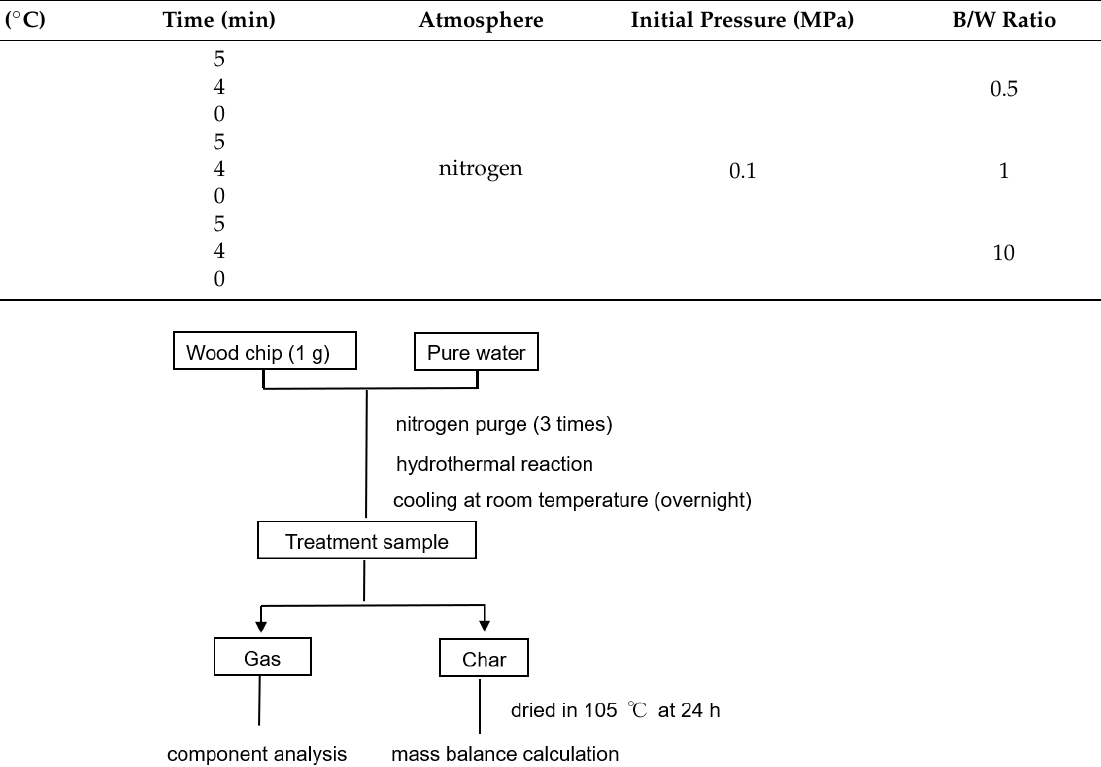
Figure 1. Schematic diagram of a hydrothermal reactor. 1 = pressure gauge; 2 = reactor body; 3 = heater; 4 = thermocouple; 5 = control unit.